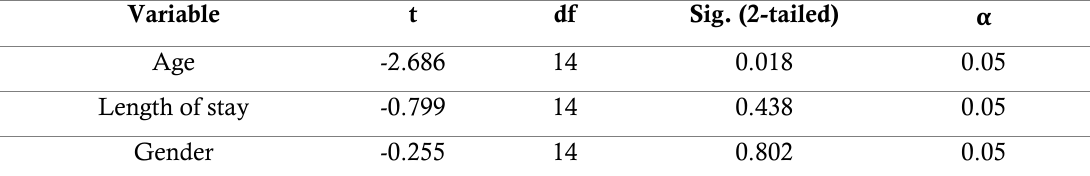
Table 5 Results of Paired Sample t-test Disposing of Garbage Behavior in Trash